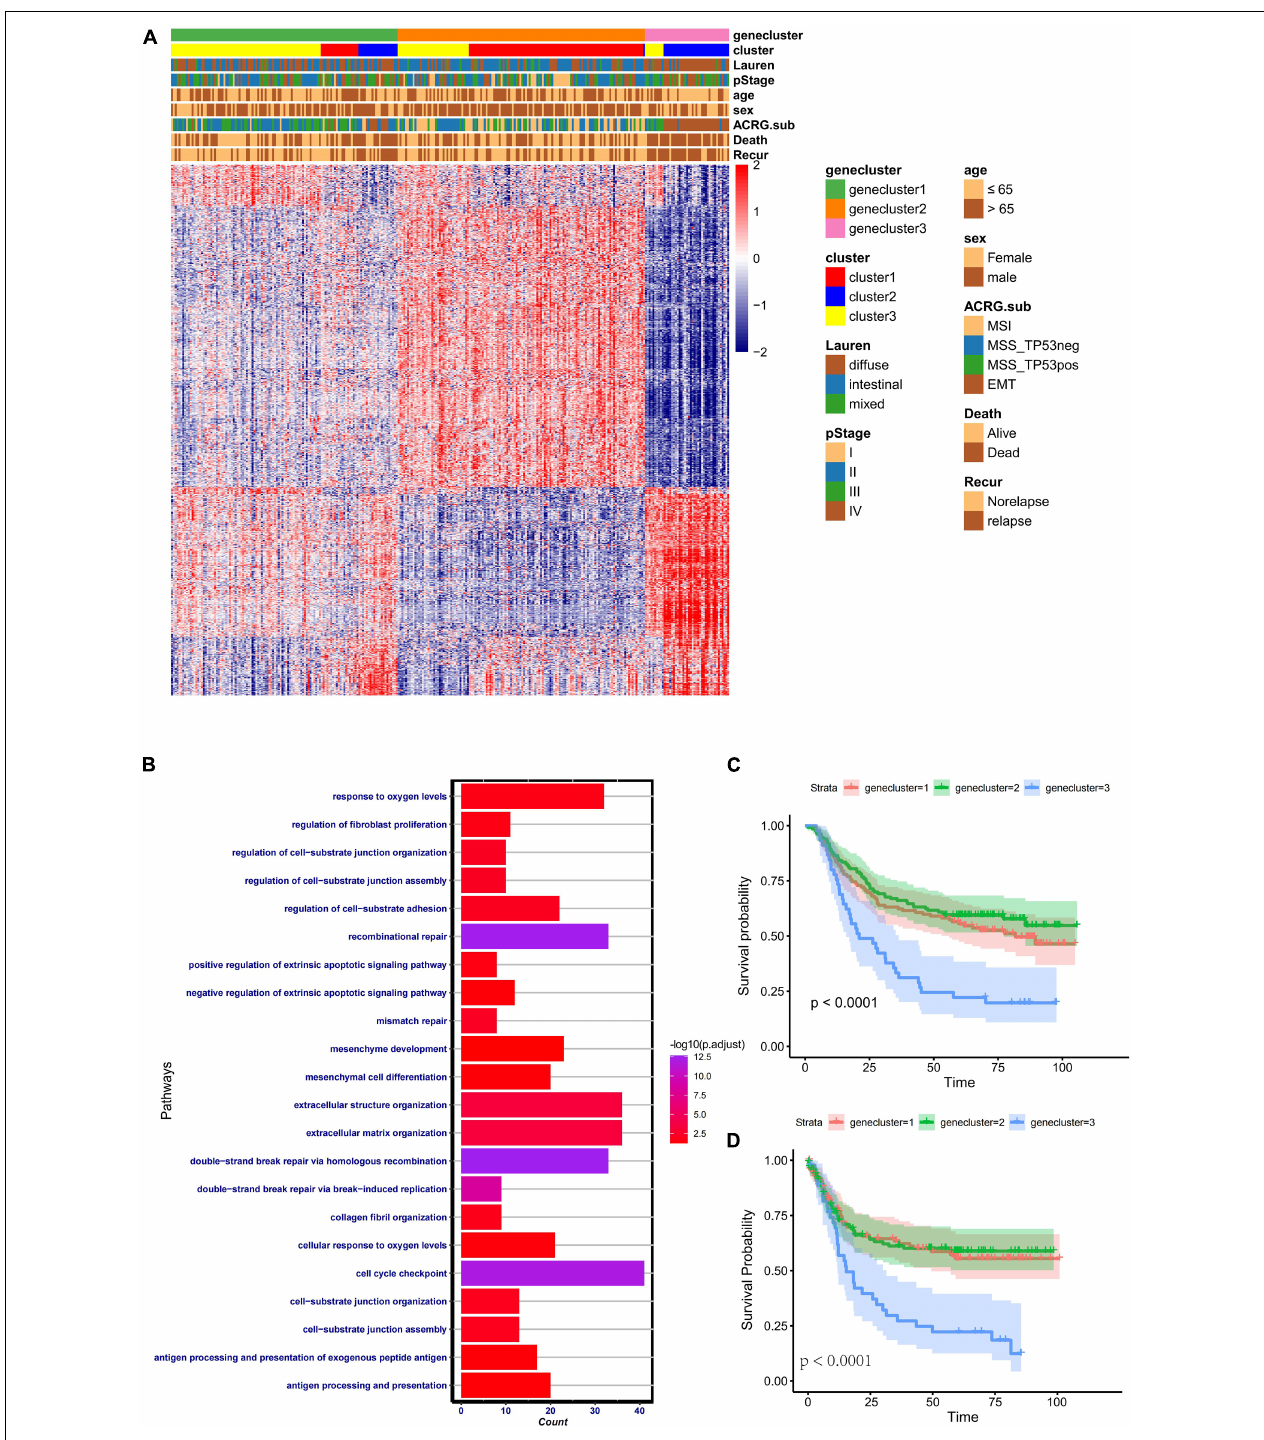
FIGURE 4 | Clinical features and transcriptome characteristics of distinct gene clusters. (A) Unsupervised clustering for the 933 overlapping ferroptosis-related genes classified patients in the Asian Cancer Research Group (ACRG) cohort into three gene clusters with distinct biological characteristics. The gene clusters, ferroptosis-related clusters, ACRG molecular subtypes, histology subtype, tumor stage, survival status, relapse status, gender, and age were used as patient annotations. (B) Gene Ontology (GO) biological pathway enrichment analysis for the 933 overlapping phenotype-related genes. (C) Kaplan–Meier analysis of patients in three different ferroptosis-related gene clusters in the ACRG cohort. (D) Relapse-free survival analysis of the patients in three different ferroptosis-related gene clusters in the ACRG cohort.